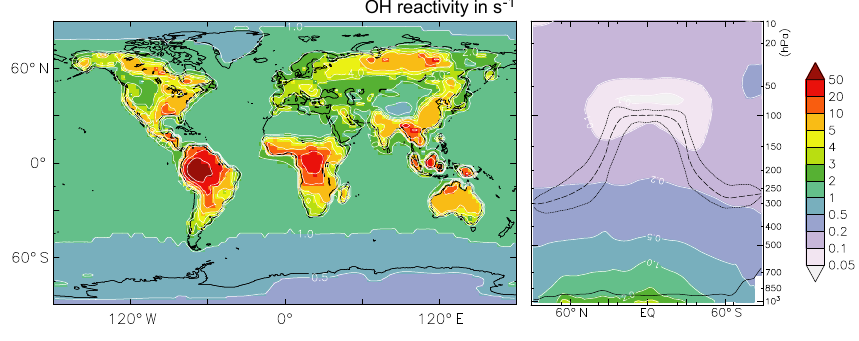
Figure 5. Annual mean OH reactivity near the Earth’s surface in s − 1 .